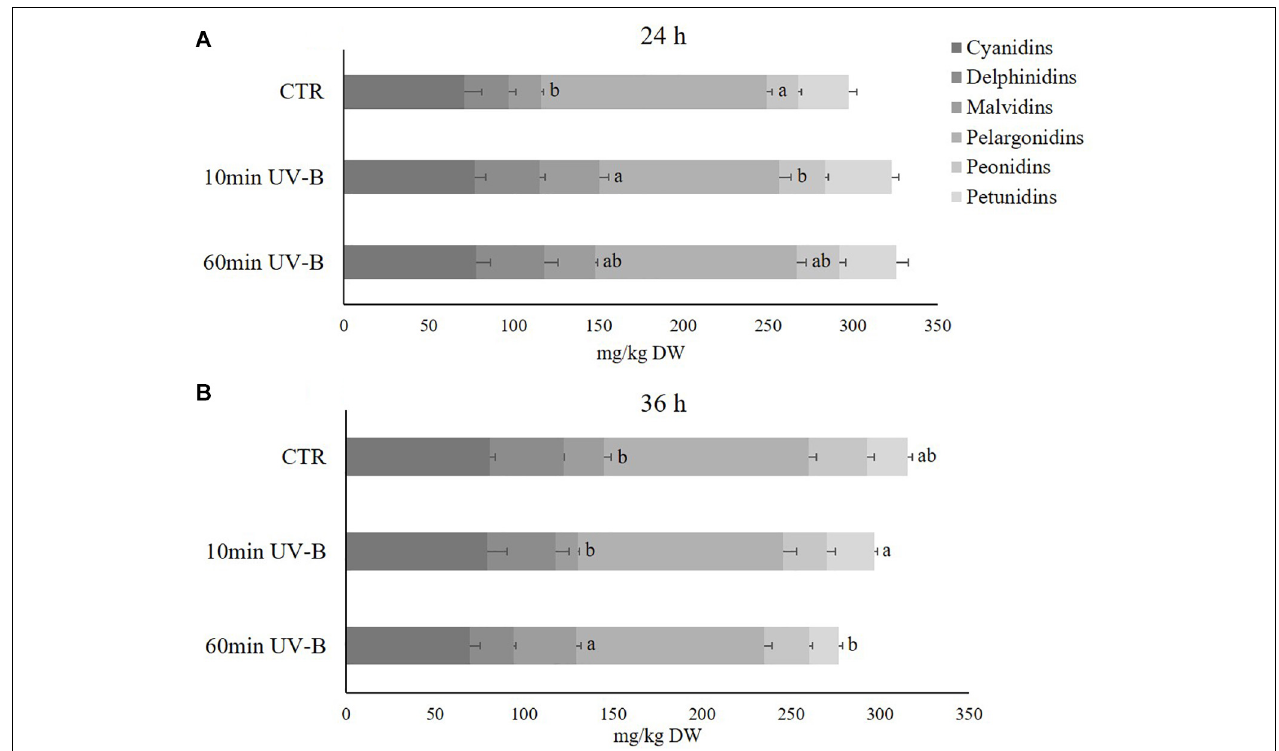
FIGURE 6 | Concentration (mg/kg DW) of different anthocyanins (cyanidins, delphinidins, malvidins, pelargonidins, peonidins, and petunidins) in the pulp of peaches exposed to UV-B radiation for either 10 or 60 min and sampled after 24 h (A) and 36 h (B) from the exposure. Data are mean ± SE of five biological replicates. Different letters correspond to statistically significant differences according to one-way ANOVA followed by Tukey–Kramer post hoc test ( P ≤ 0.05).